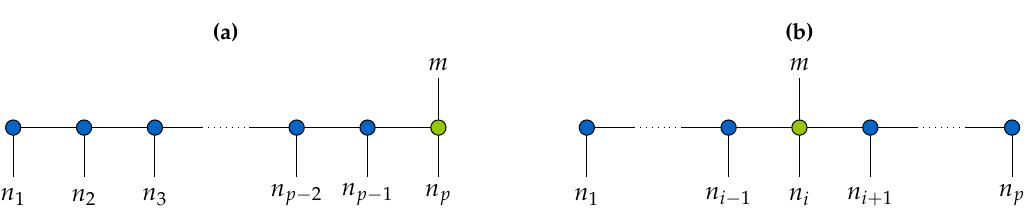
Figure 3. TT representation of transformed data tensors: ( a ) As in [13], the first p cores (blue circles) are given by (17). The direct contraction of the two last TT cores in (17) can be regarded as an operator-like TT core with a row and column mode (green circle). ( b ) The additional column mode can be shifted to any of the p TT